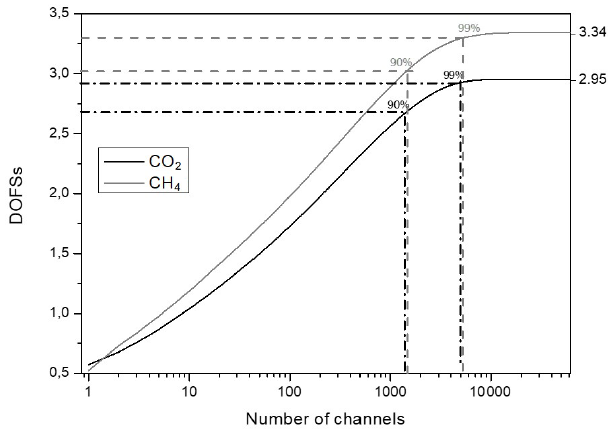
Figure 12. Evolution of the DOFSs with the number of selected channels for CO 2 (black) and CH 4